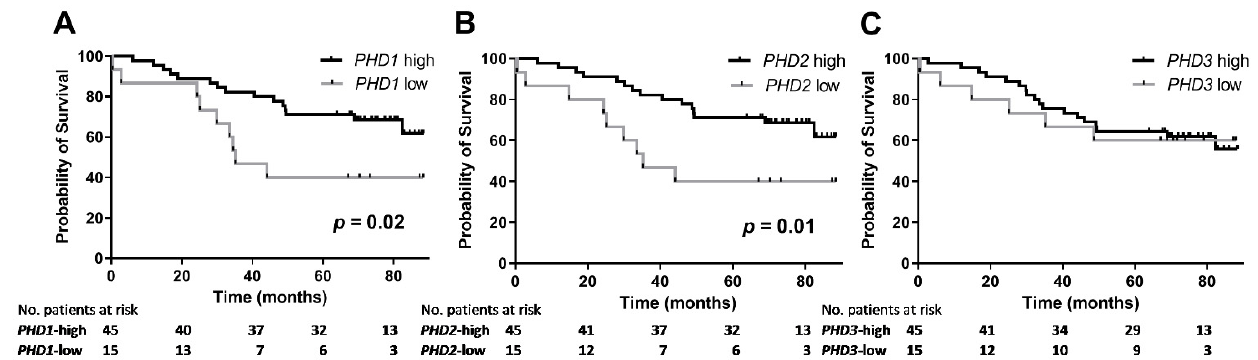
Figure 3. Kaplan–Meier survival curves for overall survival after surgery according to ( A ) PHD1 , ( B ) PHD2 and ( C ) PHD3 mRNA expression levels in the primary tumours of 60 patients with surgically resected non-small-cell lung cancer (NSCLC). The plots show survival rates for patients with low PHD1 / PHD2 / PHD3 expression (grey line) vs. patients with high PHD1/PHD2/PHD3 expression (black line). Table 4. Univariate and multivariate Cox proportional hazards regression model analyses of survival.